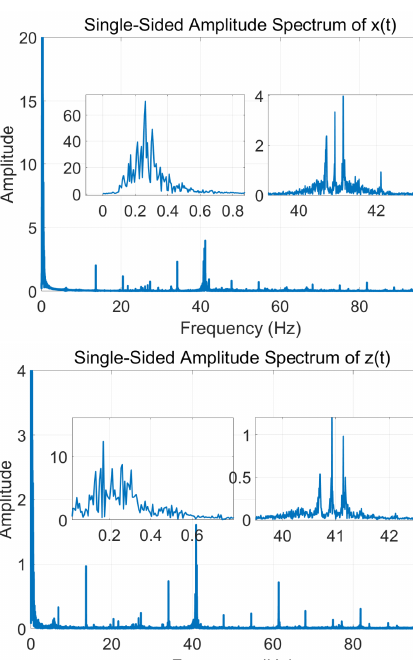
started at the same time, and the accelerometer data were also collected at 200 Hz for ap- proximately 1 h, and the frequency spectrum distribution on each axis in the corresponding time period was counted. The results are plotted in Figure 6, respectively: